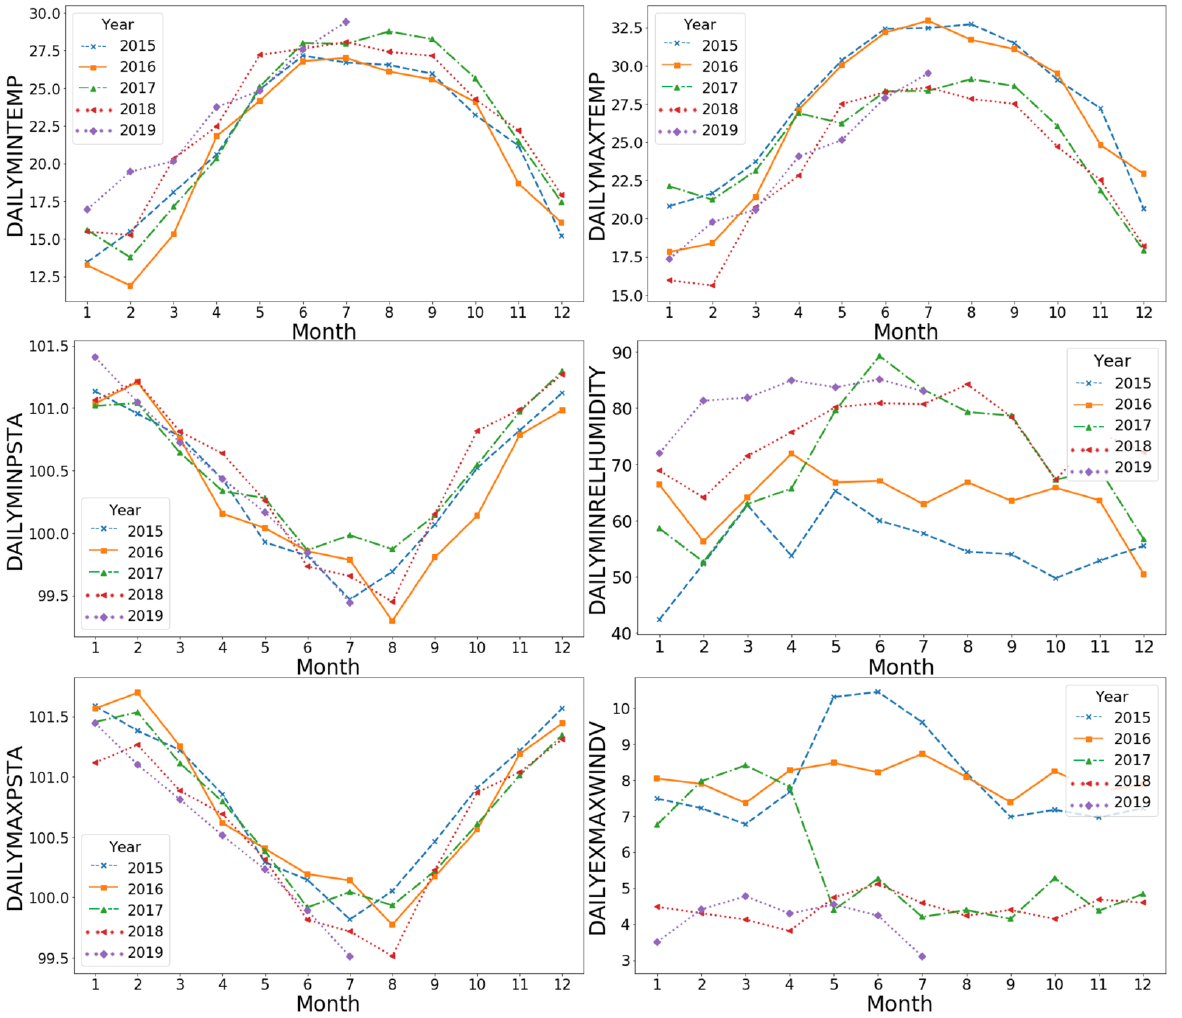
Figure 1. The monthly data trend of daily meteorological indicators in the past five years.